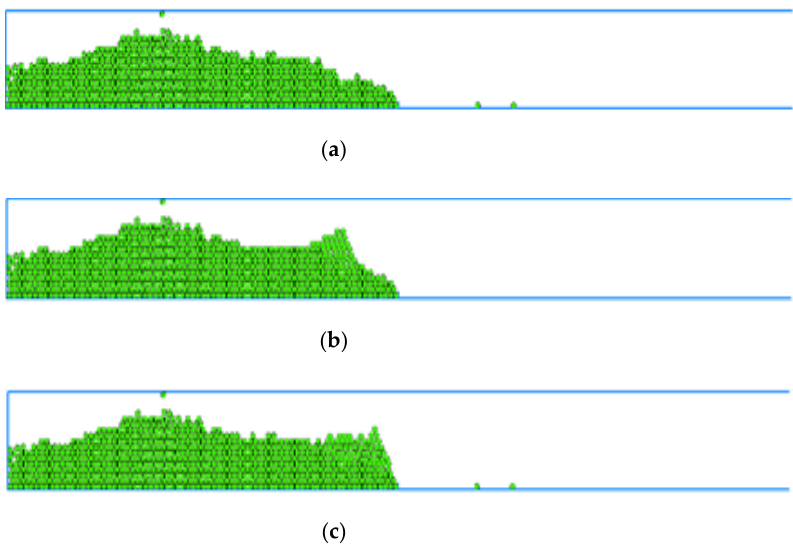
Figure 9. The effect of internal friction angle on blockage of drainage pipe. ( a ) Internal friction angle 20°. ( b ) Internal friction angle 30°. ( c ) Internal friction angle 40°.